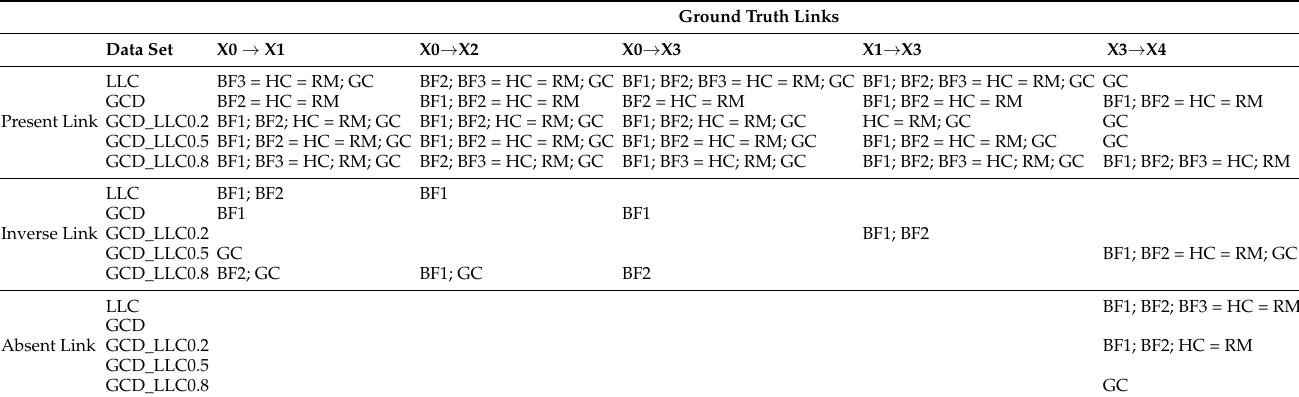
Table 11. Grouping of causality graphs obtained from the Bayes networks and Granger experiments (GC) for each synthetic data set. We compared the graph links with the ground truth links (columns) in Figure 7. The link can be Present (present link in the graph and ground truth), Inverse (present link with an inverse direction), Absent (absent link in the graph and present in ground